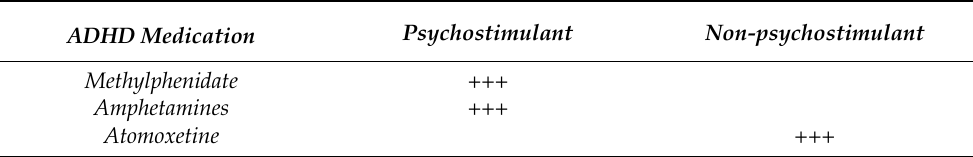
Table 2. Psychostimulant and non-psychostimulant medication for ADHD.